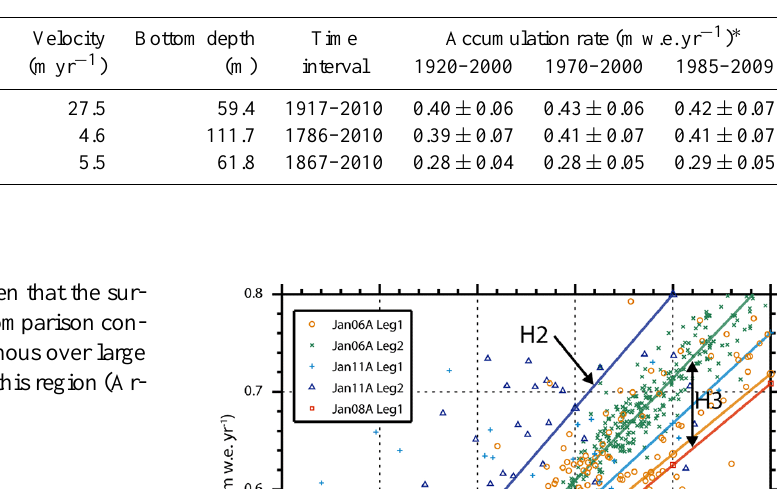
Table 1. Summary of ice-core accumulation records.